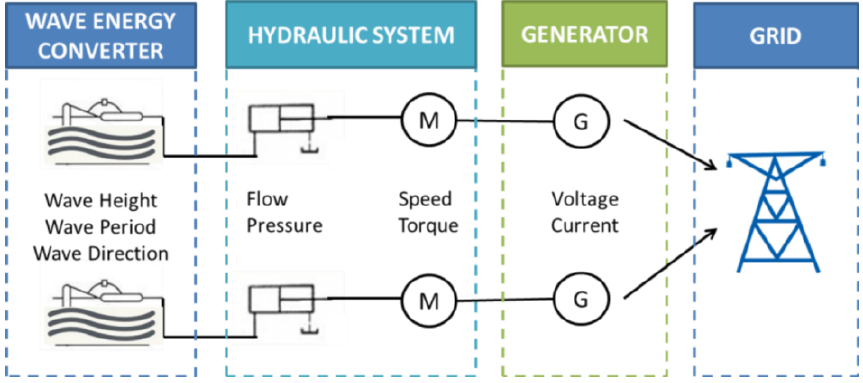
Figure 1. Schematic diagram of the wave power generation system.